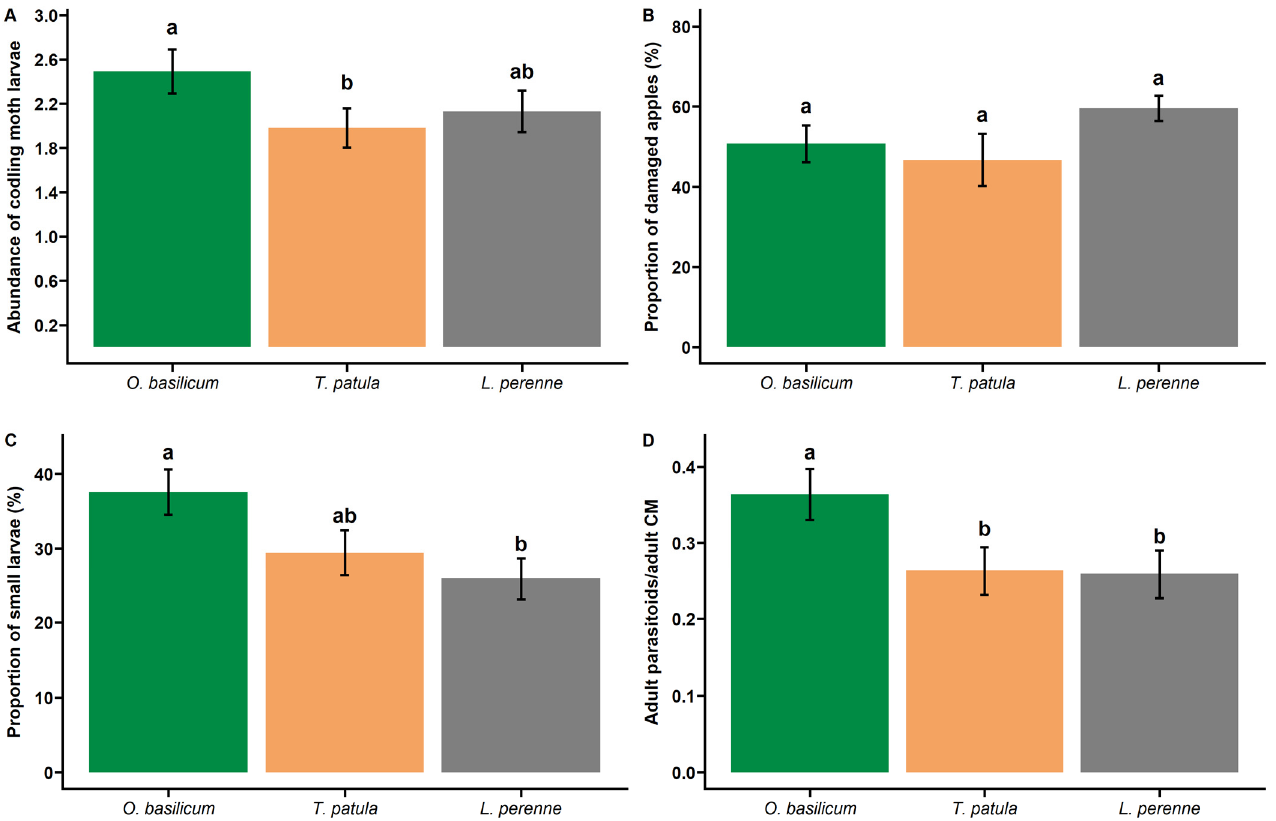
Figure 2. Comparison of ( A ) the mean number of codling moth larvae per apple tree and week, ( B ) the mean proportion of apples with codling moth damage per tree, ( C ) the mean proportion of small codling moth larvae (<30 mg) per apple tree and week, and ( D ) the mean ratio of adult parasitoids to adult codling moths in Ocimum basilicum , Tagetes patula, and Lolium perenne inter-cropping plots. Bars represent standard errors. Different letters indicate significant differences between aromatic plants ( p < 0.05).